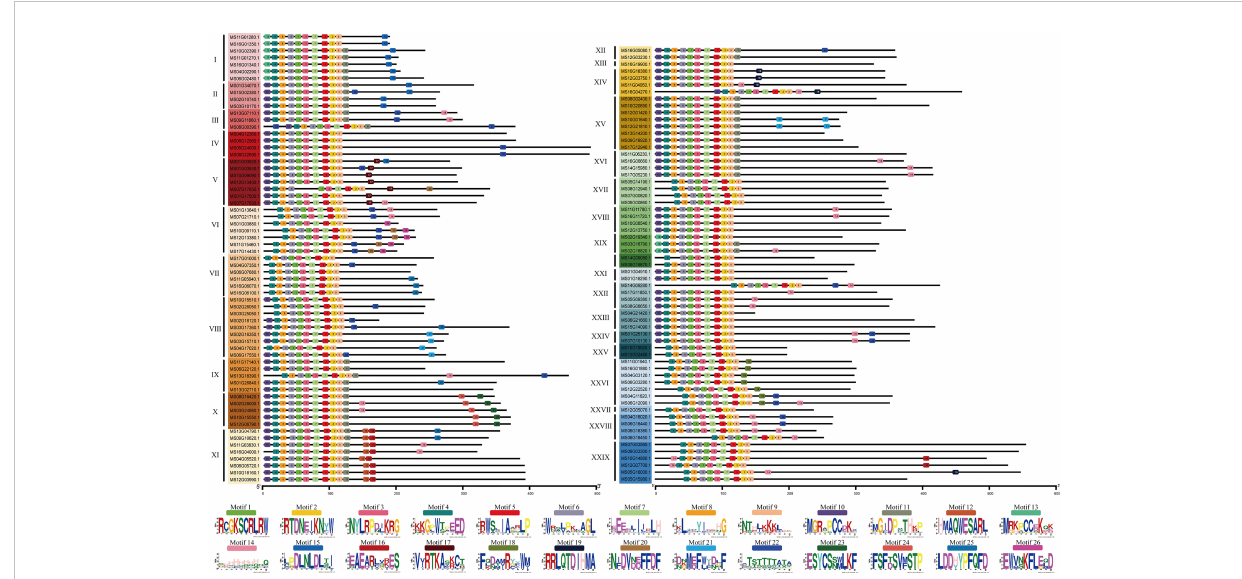
FIGURE 2 Motif composition of R2R3-MYBs in Malus sieversii . Roman numbers and different colors indicate different groups. Each solid line length indicate the different protein sequences length. The 9 Colored boxes indicate different motifs, which composes the MYB conserved domain region.